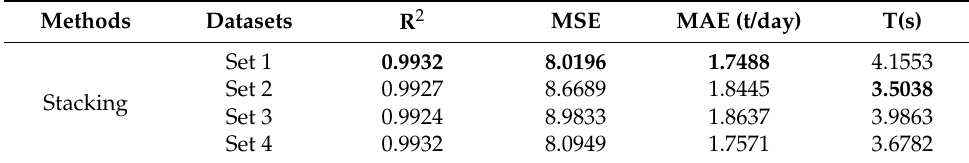
Table 3. Effects of wind, wave and current factors on the results of the proposed model.